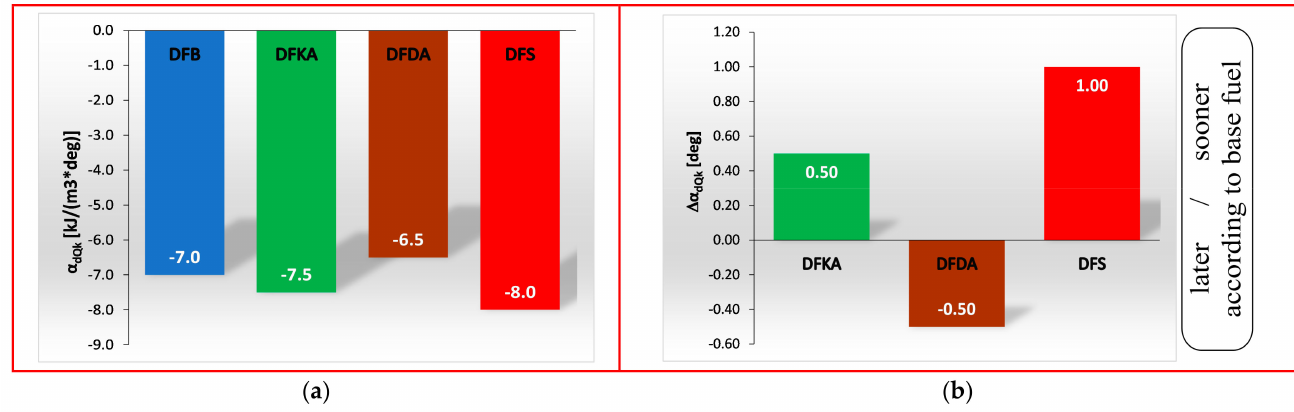
Figure 20. ( a ) Maximum rate of kinetic combustion ( α dQk ) for tested fuels. ( b ) Maximum rate of diffusion combustion ( α dQd ) for tested fuels.